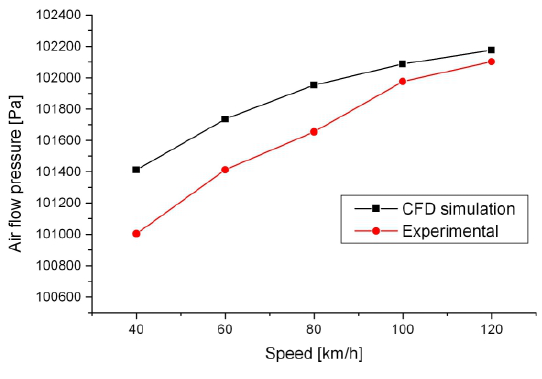
Figure 9. Comparative analysis of CFD simulation vs. experimental tests results.